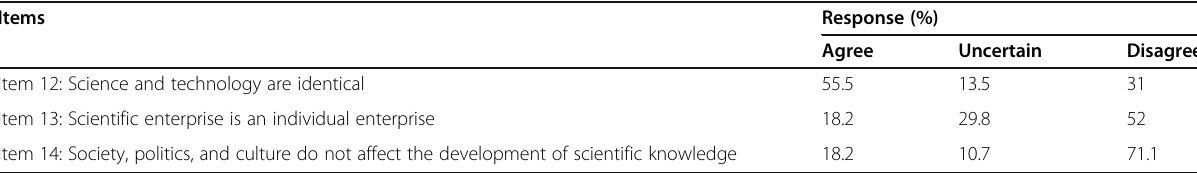
Table 6 Perceptions of the NOS: Scientific Enterprise ( N = 225) Items Response (%)